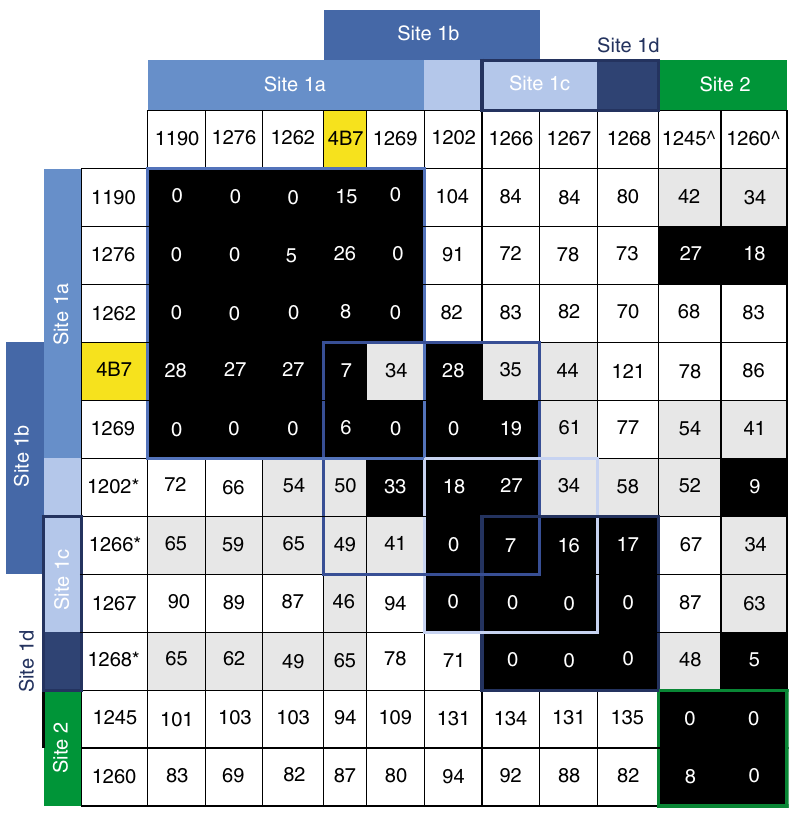
Fig. 2 Epitope binning of anti-Pfs25 Kymouse-derived human antibodies. Primary antibodies tested are listed in the left column, while secondary competing antibodies are listed at the top in rows. Data indicate the percent of competing antibody binding compared to the maximum competing antibody response in the absence of the primary antibody. Boxes are colored according to competition status. Competing antibodies that displayed ≤ 33% maximal binding are colored black and considered competing, between 34 and 66% binding are considered intermediate and colored gray, and those that displayed ≥ 66% binding are colored white and considered non-competing. Epitope bins are listed above or beside the table, with site 1 competing antibodies colored in shades of blue and site 2 competing antibodies colored green. *Primary antibodies displayed a fast off-rate, resulting in intermediate binding values for true non-competing antibodies. ^Competing antibodies displayed a slow on-rate, leading to low values. The well-characterized mouse mAb 4B7 is highlighted in yellow as a (Supplementary Fig. 4L and Supplementary Table 2), and dis- plementary Fig. 4M and Supplementary Table 2). Antibodies